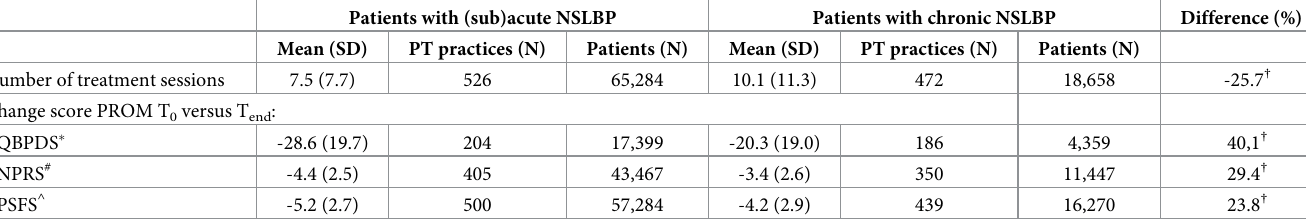
Table 6. Validity analysis on the NSLBP sample of the total clinical registry, using the known-groups validity to divide the NSLBP-sample in two